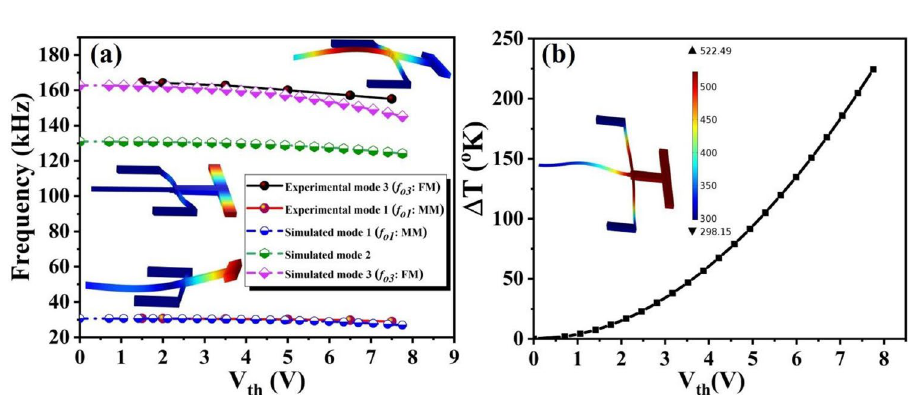
Figure 2. Experimental and finite-element results for an uncoated device. ( a ) Experimental data and simulated results for the variation of the resonance frequency of the first three out-of-plane modes under electro-thermal actuation (V th ). Insets show their corresponding mode shapes. ( b ) Simulated results for the variaton of the temperature at the centre of the flexural beam under V th . Inset shows the temperature distrubation of the device at V th = 7.7